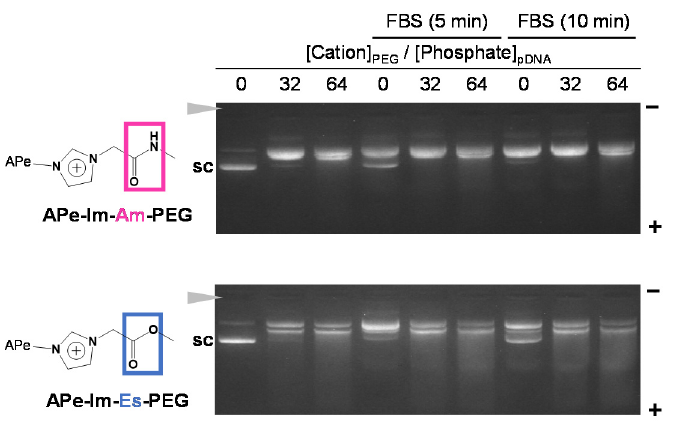
Figure 4. Stability assay of the APe-Im-Am-PEG/pDNA or APe-Im-Es-PEG/pDNA MICs ([ ω -amide-pentylimidazolium (Cation)] PEG /[Phosphate] pDNA (+/ − ) = 32 or 64) in serum protein by agarose gel electrophoresis. The MIC was incubated for 5 min or 10 min in the presence of 10% FBS, followed by loading to the gel. The solid arrowhead indicates the well where each sample was loaded. The migration band of super-coiled pDNA is indicated by “sc”.